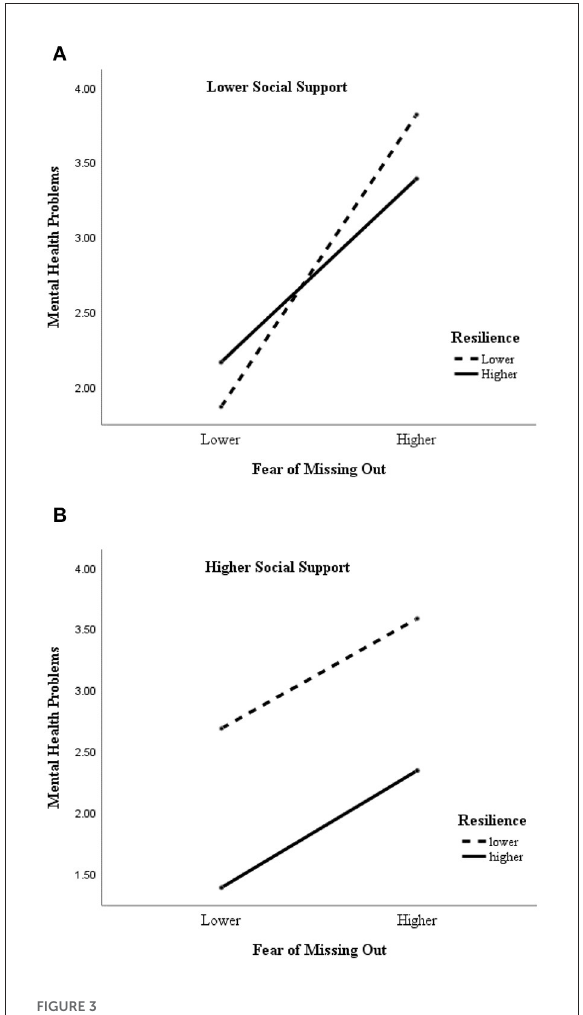
FIGURE3 (A) The moderating effect of resilience between FoMO and mental health problem under lower social support. (B) The moderating effect of resilience between FoMO and mental health problem under higher social